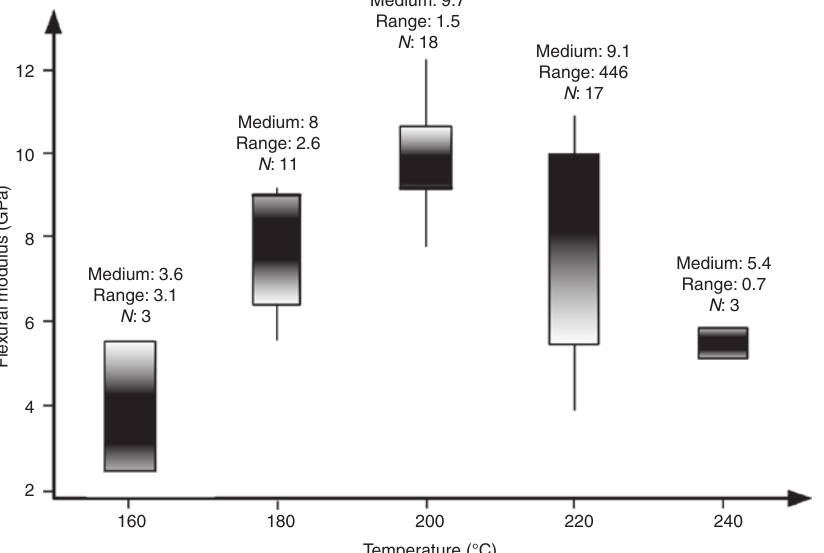
Figure 7: The effect of processing temperature on the flexural modulus of the samples ( N indicates the number of measurements, and range denotes the results variation).